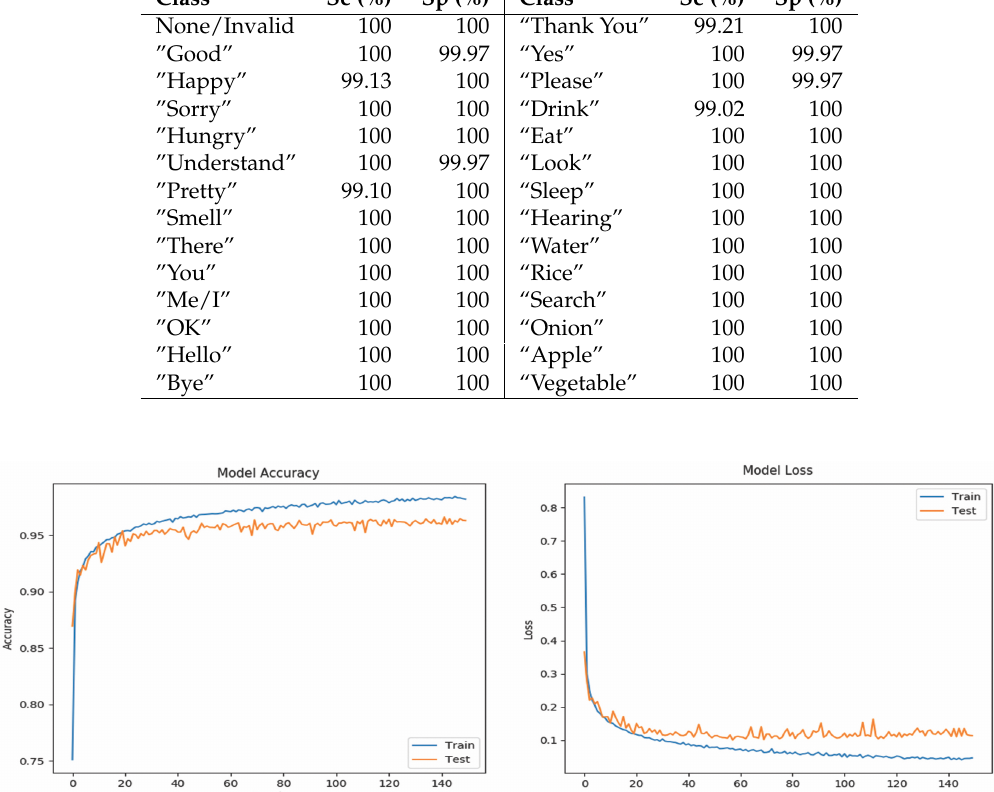
Figure 7. Performance of the trained RNN 5 with high number of neurons evaluated with mean accuracy rate ( left ) and loss function ( right ).